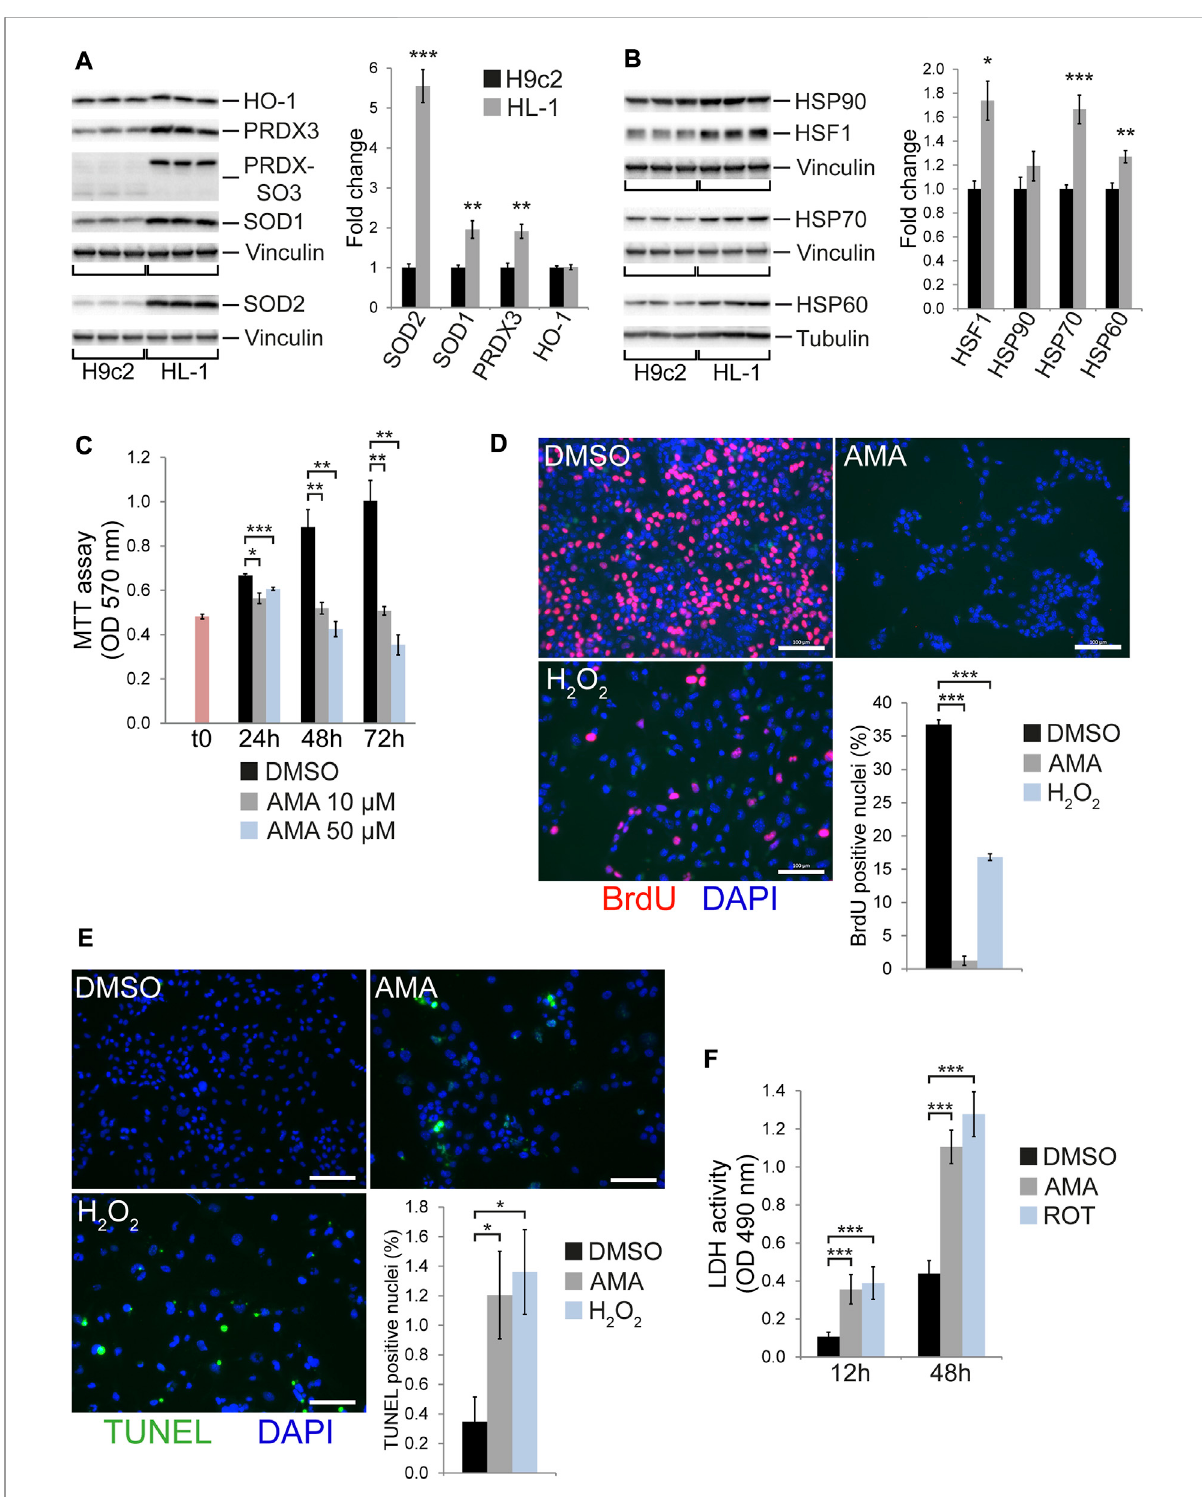
HL-1 cells undergo cell death and cell cycle arrest in response to antimycin A treatment. Western blots showing baseline expression of (A) antioxidative proteins and enzymes as well as hyperoxidized peroxiredoxin (PRDX-SO3) and (B) HSF1 and chaperones (heat shock proteins) in H9c2 compared to HL-1 cells ( n = 6 wells per group). (C) MTT assays of HL-1 cells treated with DMSO and 10 µM or 50 µM AMA for 24, 48 and 72 h ( n = 3 wells per treatment, t0 represents MTT values at the onset of treatment). (D) Fluorescence microscopy images showing